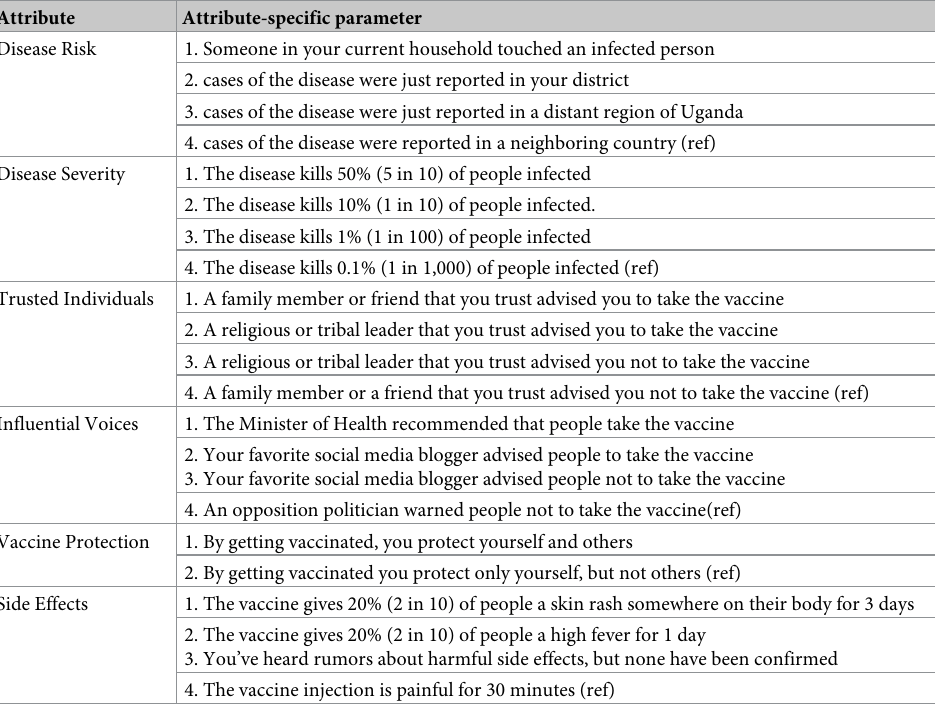
Table 1. Attributes and attribute-specific parameters for a new vaccine against an emerging disease t